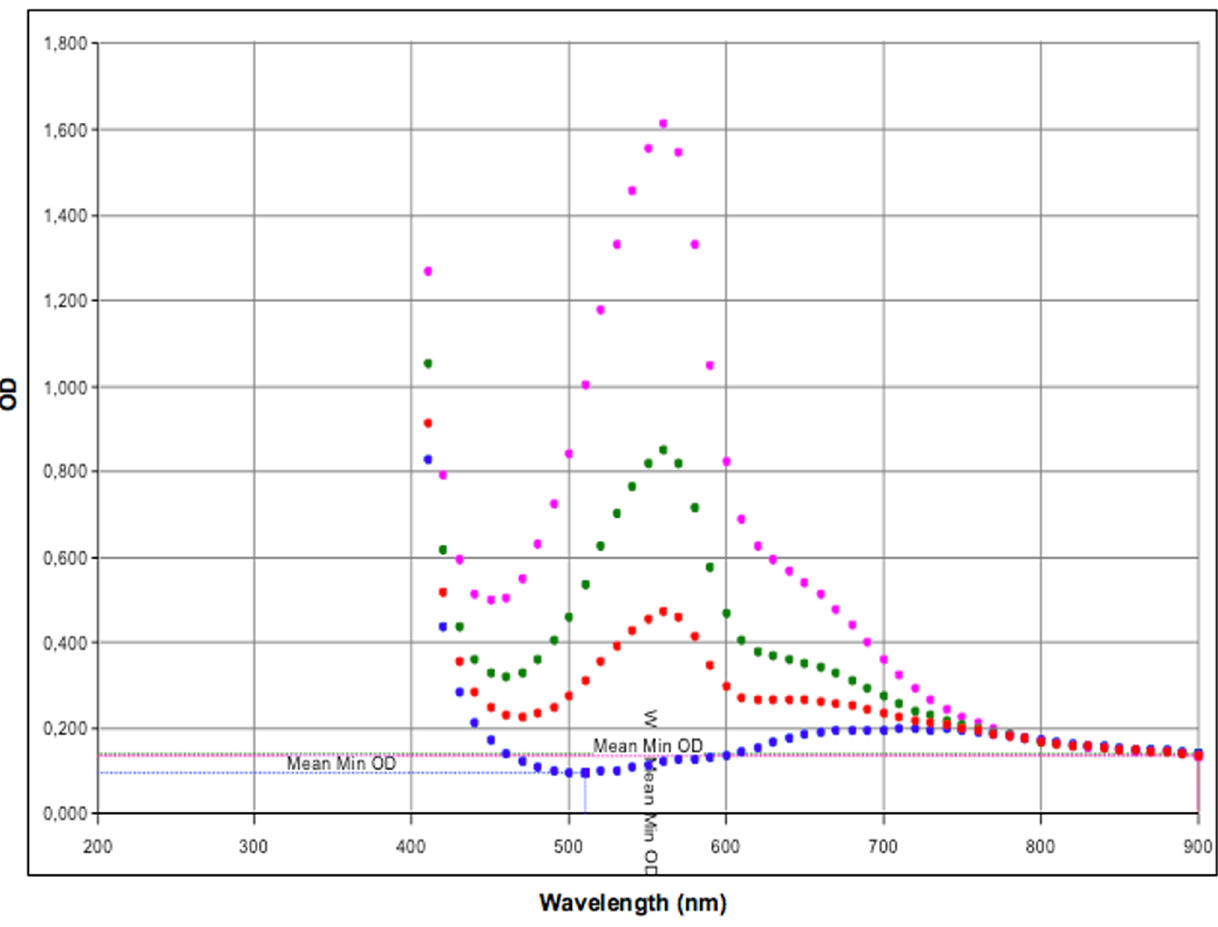
Figure 6. A summary of the overlapping spectral curves for permeated BSA. Spectral curves of permeated BSA through dermatomed human skin from sodium alginate (SA) patch (dark blue spots), and SA MNs (red spots) in 24 hours. Spectral curves of 0.5 mg/ml BSA solution (green spots), and 1 mg/ml BSA solution (pink spots). The measurements were obtained using the BCA kit.